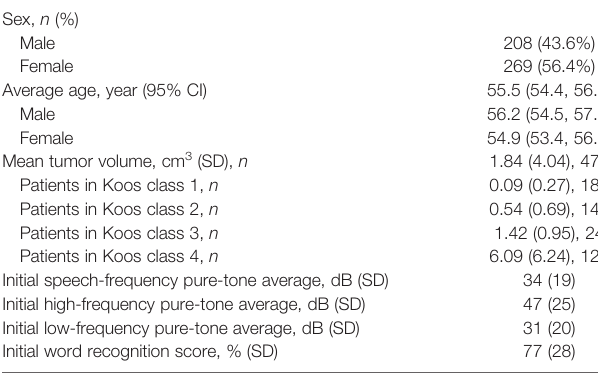
TABLE 1 | Patient demographic